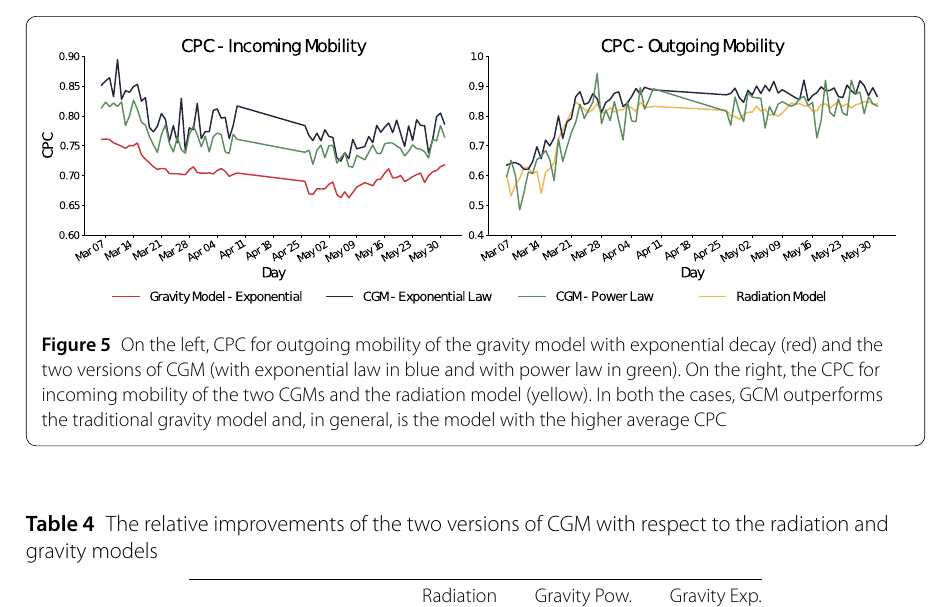
Table 4 The relative improvements of the two versions of CGM with respect to the radiation and gravity models Radiation Gravity Pow. Gravity Exp. Incoming CGM Exp. 126.91% 57.13% 11.50% CGM Pow. 118.87% 51.56% 7.55% Outgoing CGM Exp. 6.54% 60.89%